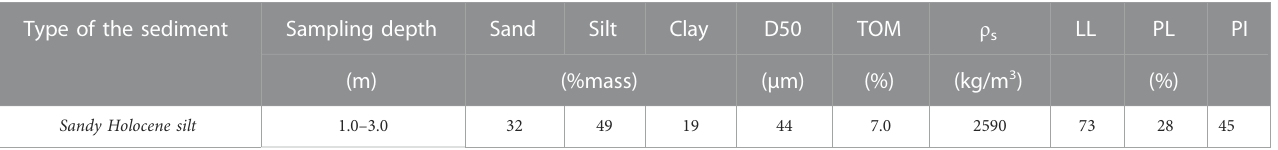
TABLE 1 Sediment properties.